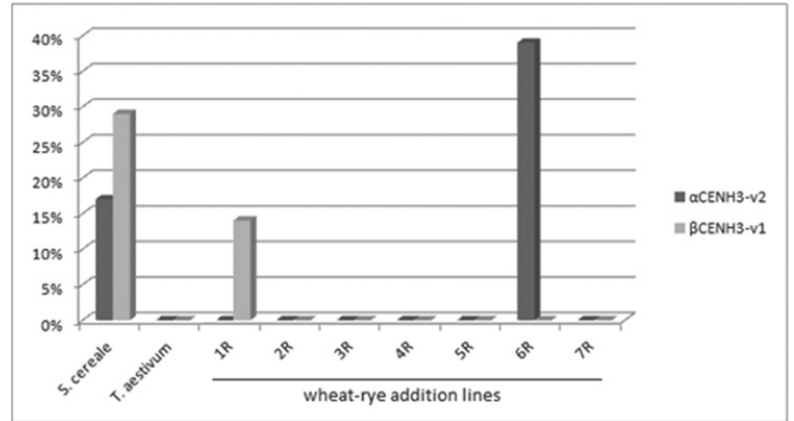
Figure 2. Histogram showing the percentage of α CENH3 -v2 and β CENH3 -v1 in the cDNA clones from rye S. cereale (cv. Imperial), wheat T. aestivum (cv. Chinese Spring) and wheat-rye (1R–7R) addition